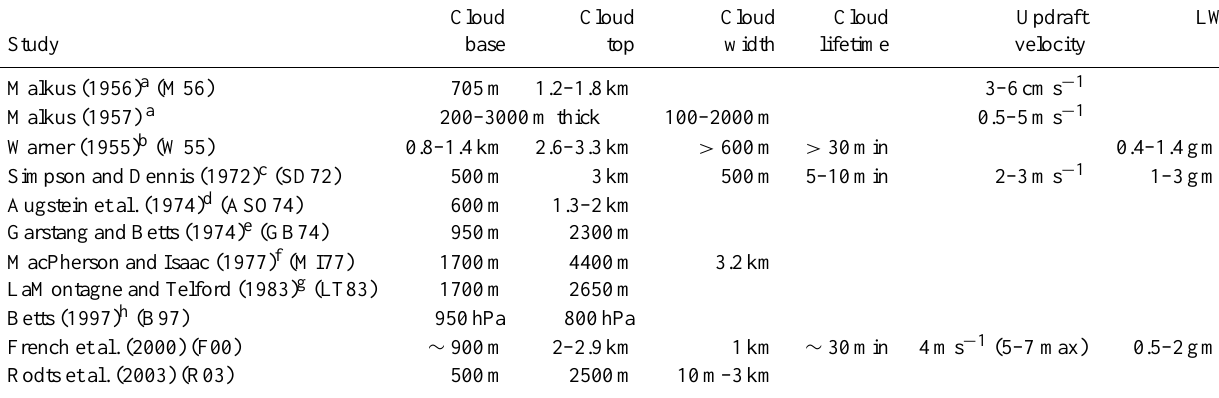
Table A1. Trade cumulus cloud properties as measured in previous studies.